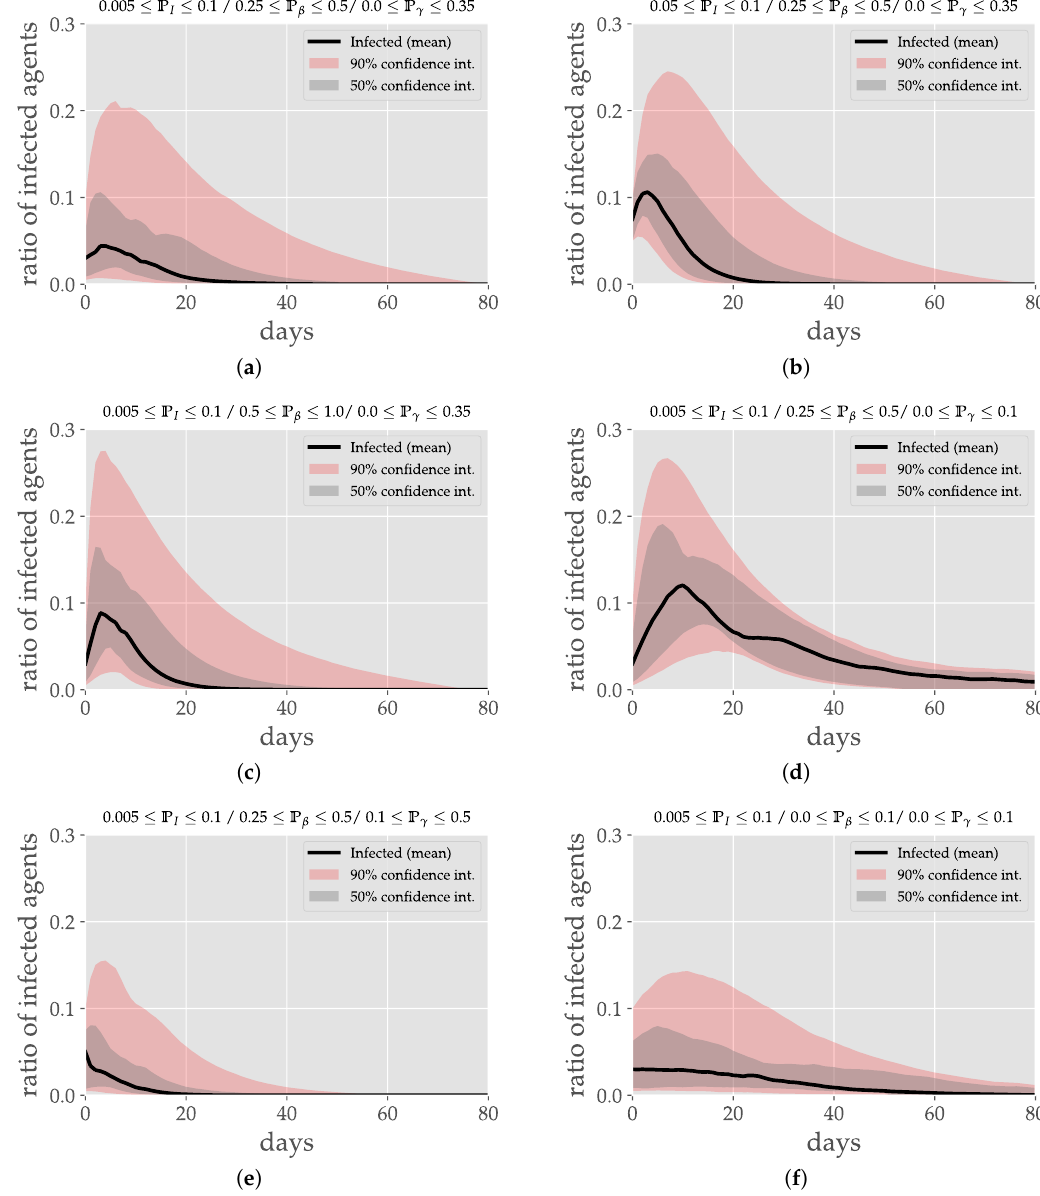
Figure 7. Some of the simulation results from the SIR model with varying input parameters P I , P β and P γ . With: ( a ) reference scenario, ( b ) increased initially infected population, ( c ) increased infection probability, ( d ) decreased recovery probability, ( e ) increased recovery probability, and ( f ) decreased infection and recovery